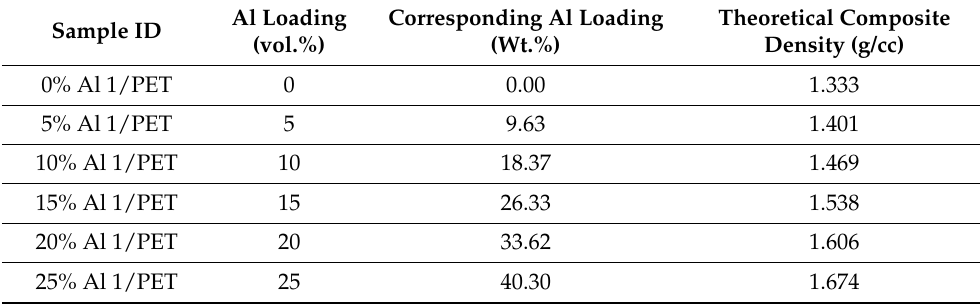
Table 2. Al loading percentages and theoretical densities of Al/amorphous PET